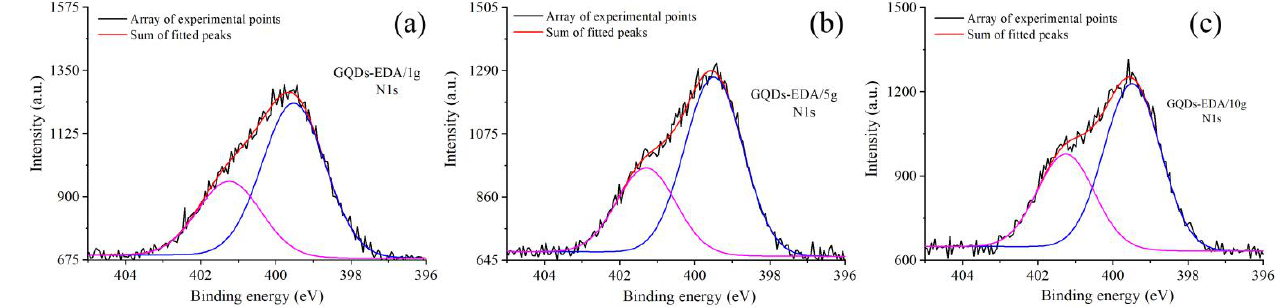
Figure 5. Analysis of high-resolution XPS spectra of N 1s region for samples GQDs-EDA/1 g ( a ), GQDs-EDA/5 g ( b ), and GQDs-EDA/10 g ( c ).